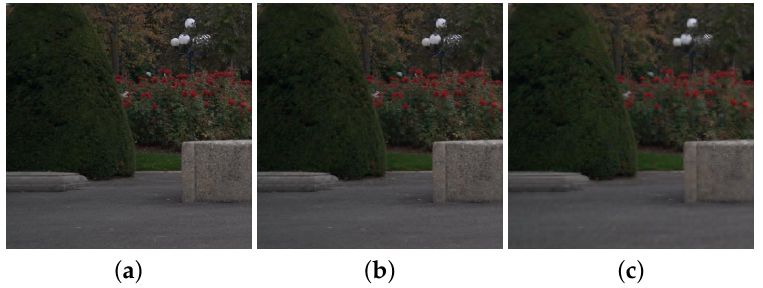
Figure 14. Fusion results from the MFD framework with different λ and β in the gradient denoising term for wavelet scale map estimation. ( a ) β = 1.2 and λ with visibility ratio; ( b ) β = 2.0 and λ with visibility ratio. ( c ) β = 2.0 and λ without visibility ratio. The visibility ratio means VI NIR / VI RGB in (14).